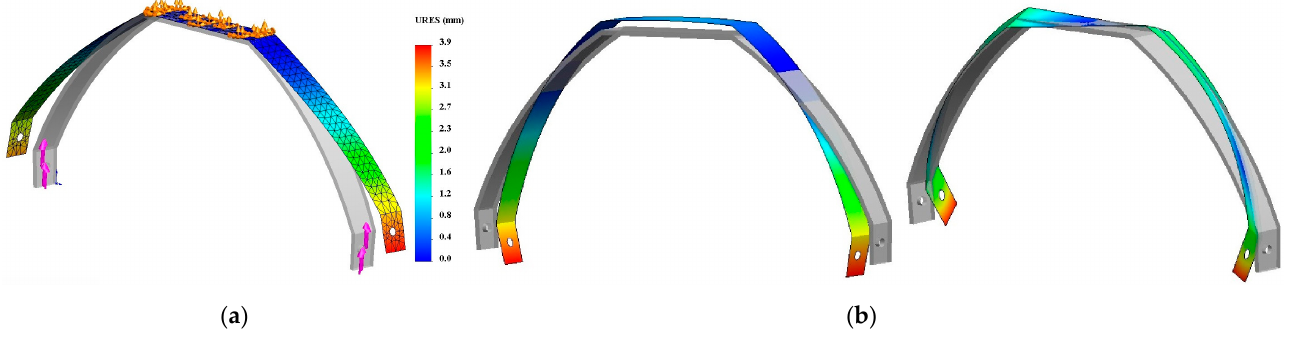
Figure 13. ( a ) Displacement of main landing gear in static study; ( b ) Main landing gear’s 1st ( left , 70 Hz) and 2nd ( right , 170 Hz) NRB mode shapes .